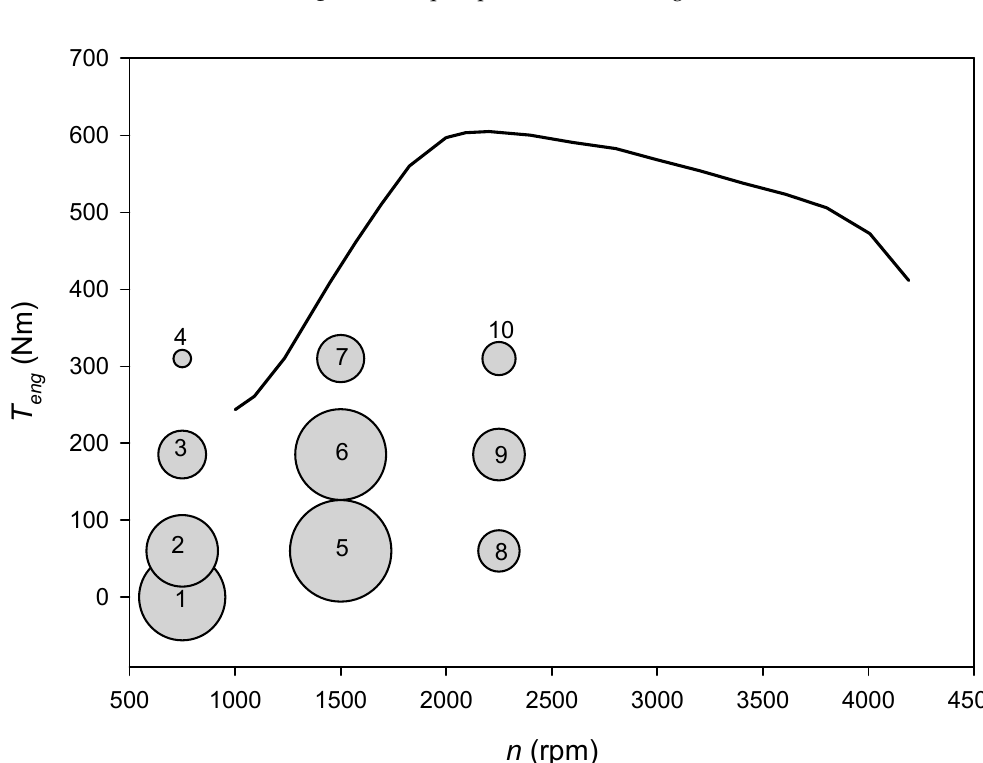
Figure 5. Engine torque curve and discretization grid points. Residence time is proportional to the bubble area.